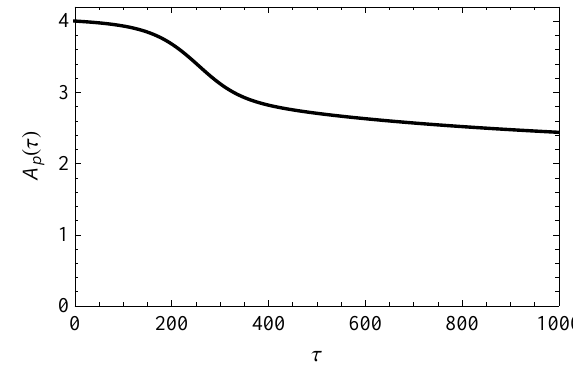
Fig. 3. Temporal evolution of both proton temperatures with respect to their initial values. Solid and dashed lines correspond to perpen- dicular and parallel temperatures, respectively.